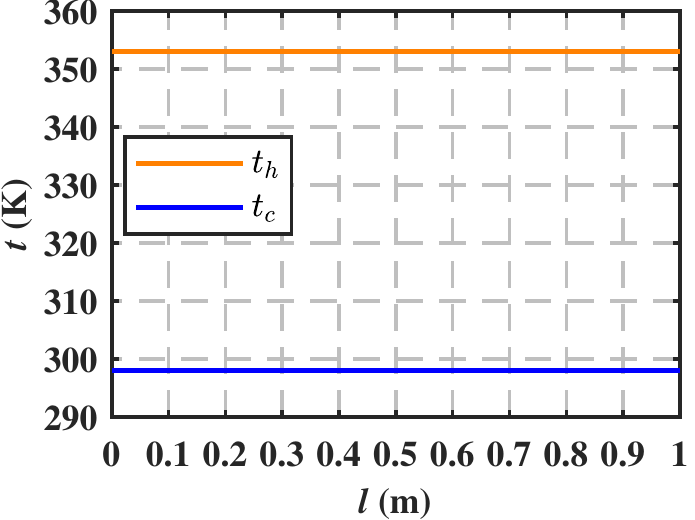
Figure 8. Temperature profiles of the streams with infinite heat capacity rates. The third main aspect discussed in this section is the amount of heat exchanged in a CFHX under a certain level of mechanical energy consumption. The parameters are kept the same as before. In this case, the working fluids at both sides are liquid water, whose physical parameters are considered as same. Hence, the certain total mechanical energy consumption means that the corresponding total heat capacity rate is fixed and can be expressed as 2 GC = G h C h + G c C